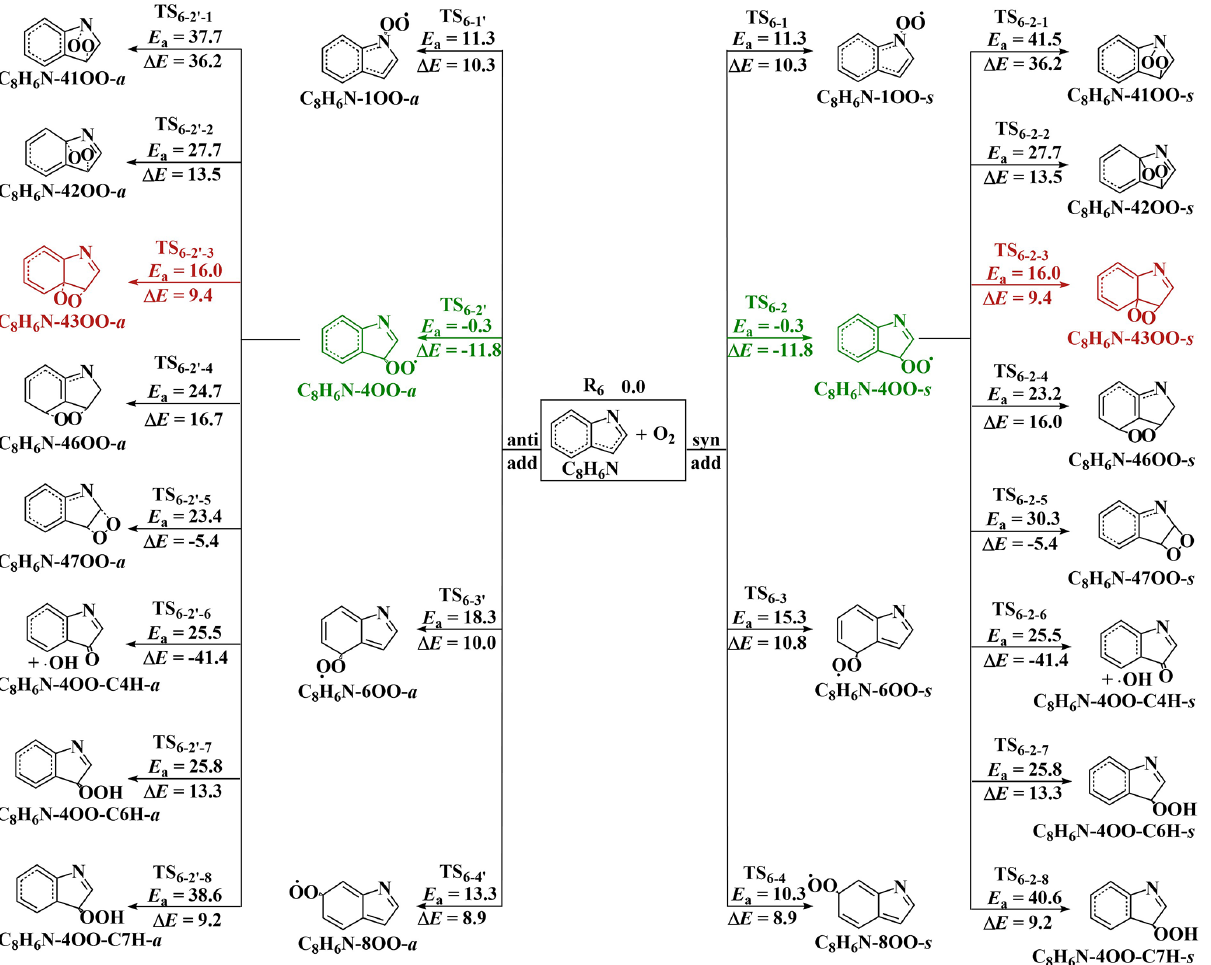
Figure 4. Reaction pathways and corresponding energetic data for the reactions of C 8 H 6 N radicals with O 2 . Units are in kcalmol − 1